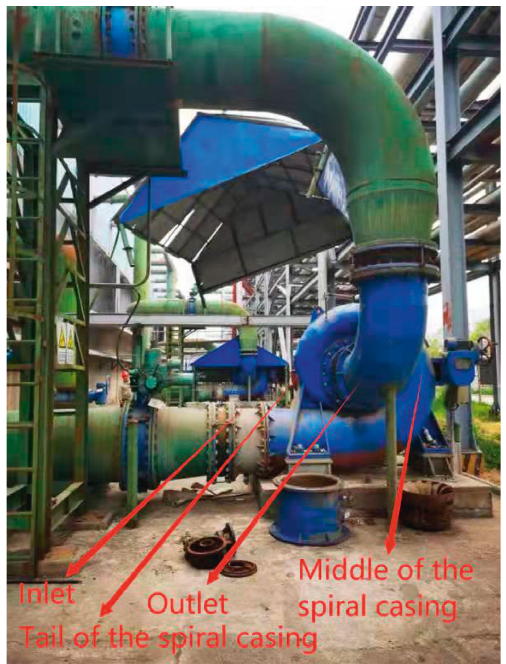
Figure 3: Measuring point layout of the residual pressure utili- zation hydraulic unit.